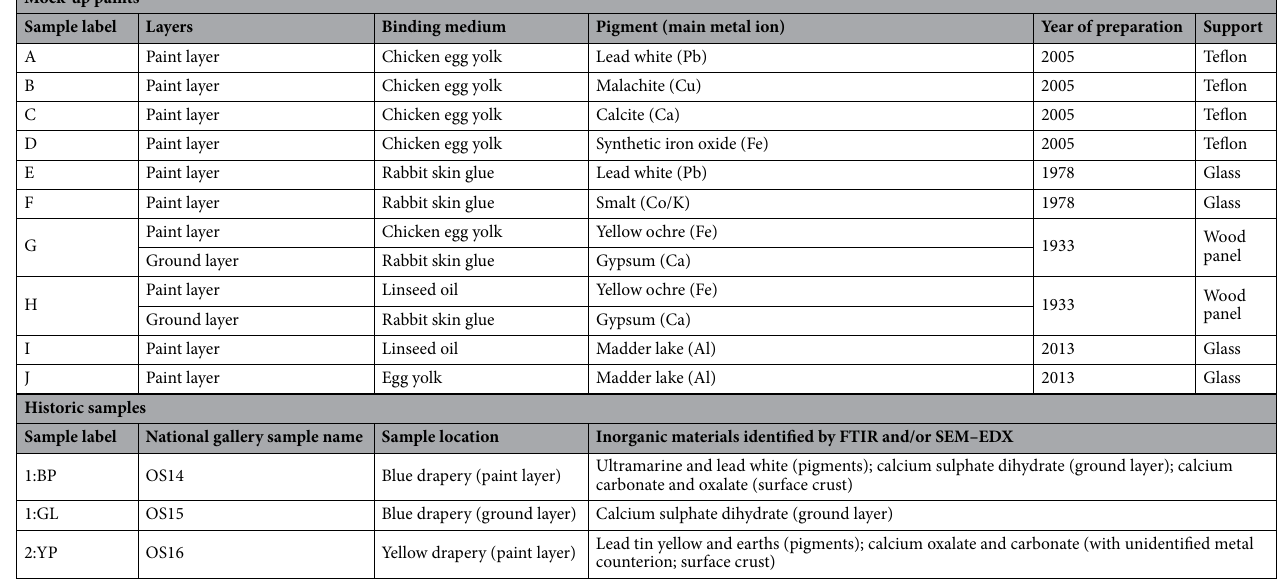
Table 1. Description of the complete set of analysed materials: mock-up paints, and samples collected from “The Virgin and Child with Saint John and an Angel”